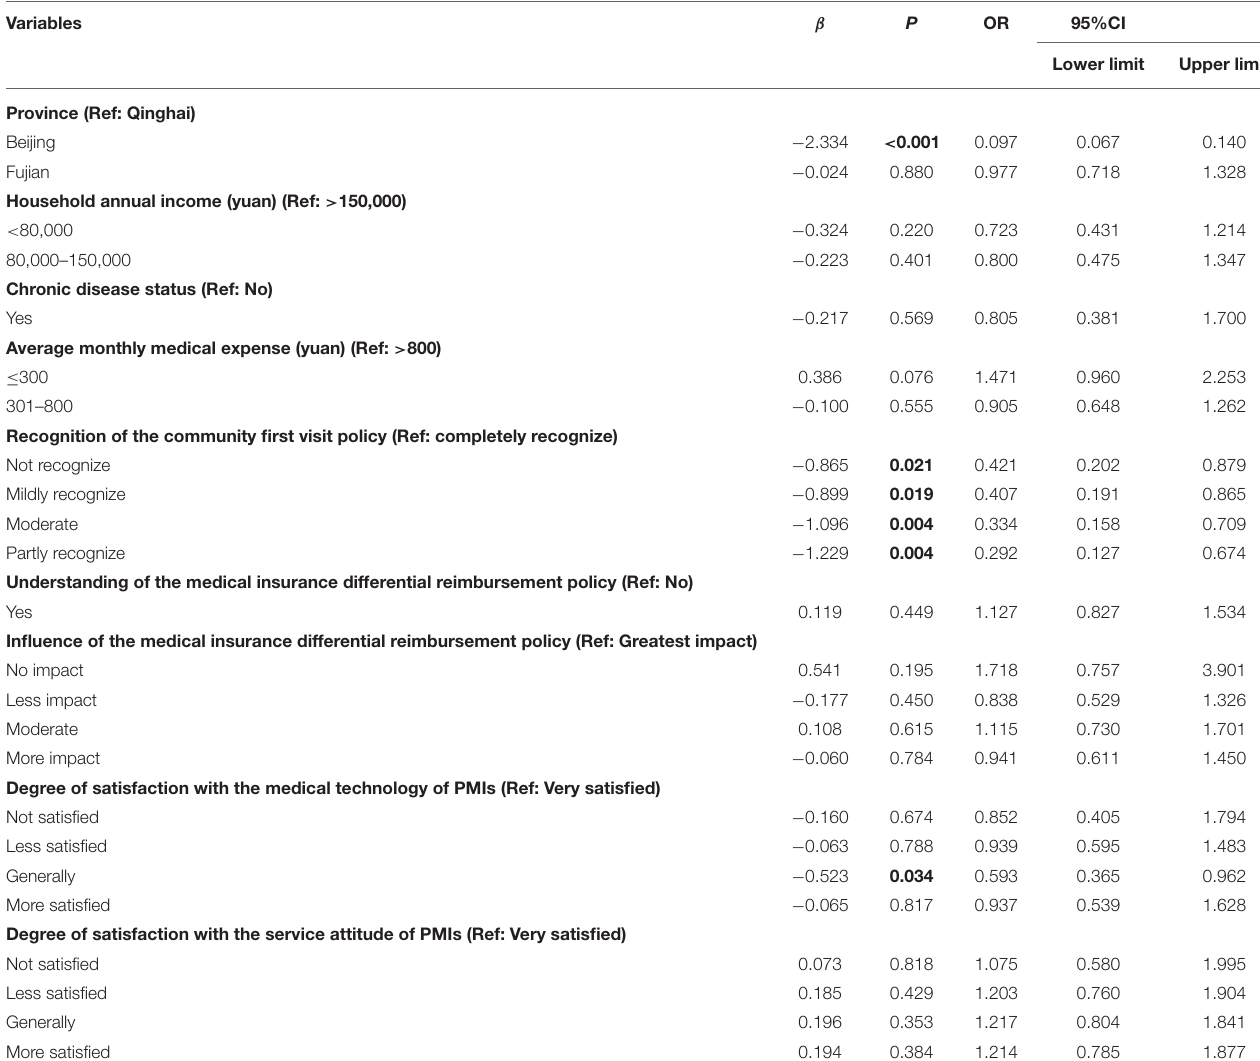
TABLE 2 | Binary logistic regression analysis of patients’ willingness of first visit in PMIs. Variables β P OR 95%CI